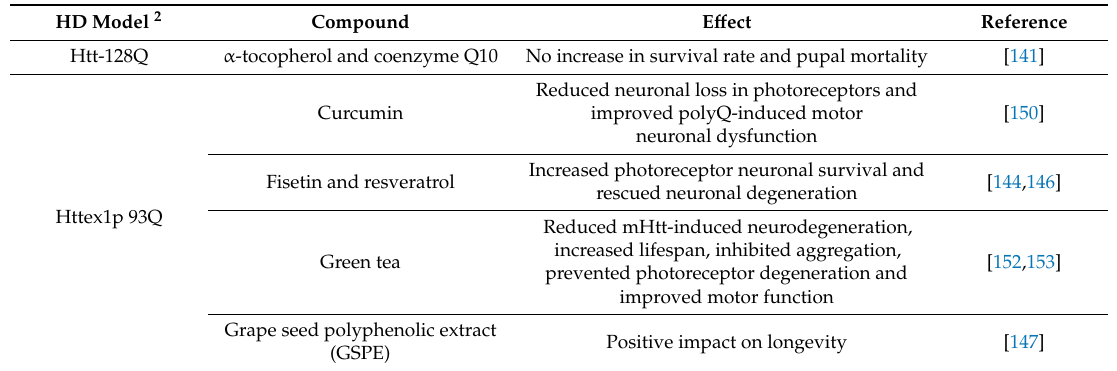
Table 2. Antioxidant therapies carried out in Drosophila melanogaster 1